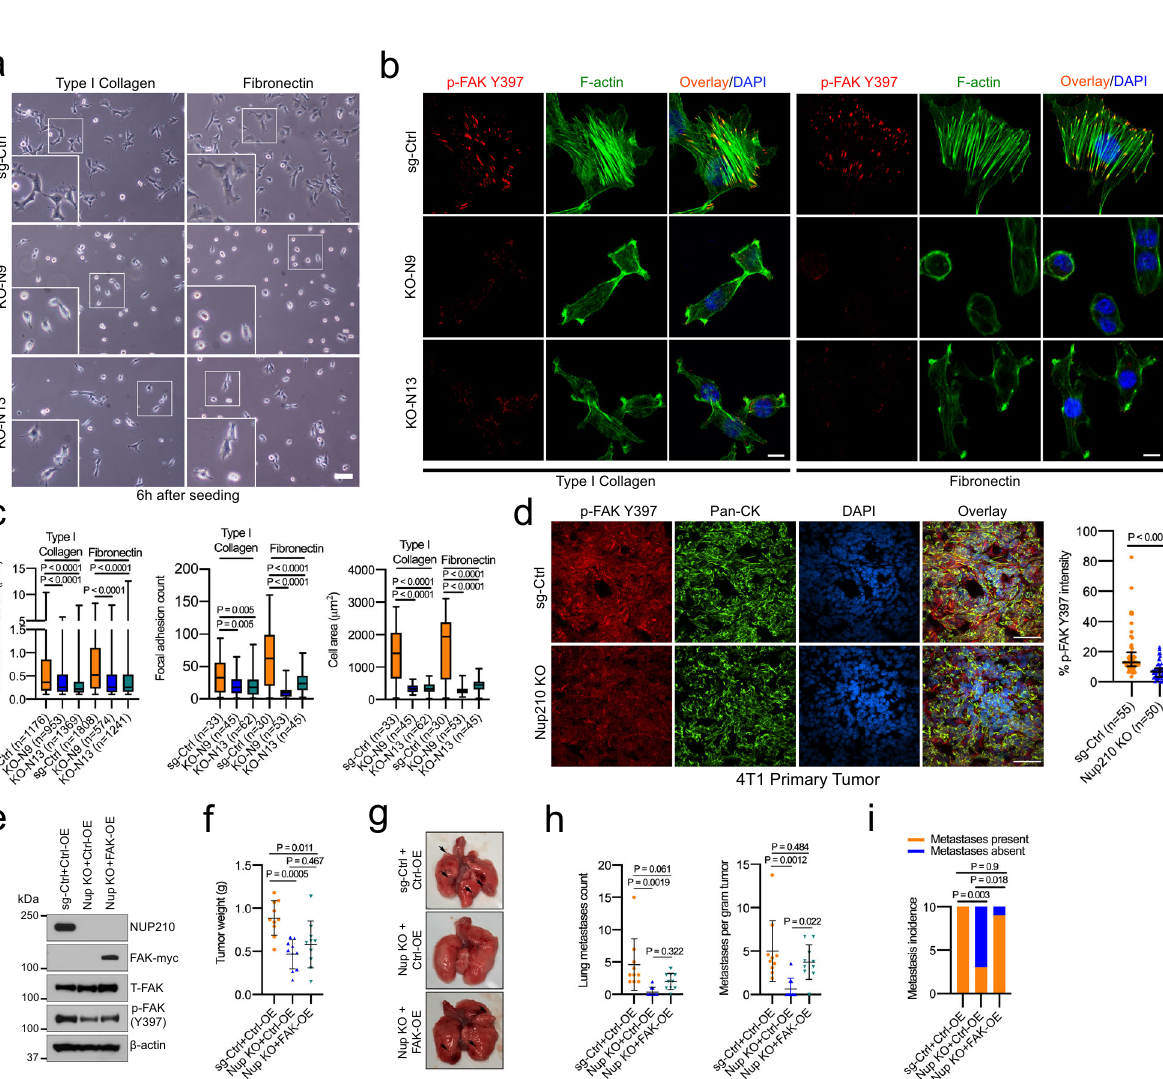
Fig. 5 Loss of NUP210 is associated with H3K27me3-marked heterochromatin spreading in 4T1 cells. a H3K27me3 peak enrichment on gene bodies in Nup210 KO cells within NUP210-enriched regions. b H3K27me3 ChIP-seq pro fi le in sg-Ctrl and Nup210 KO cells. c H3K4me3 ChIP-seq pro fi le on gene promoters in sg-Ctrl and Nup210 KO cells. d Overlap of genes with H3K4me3 loss on the promoter and downregulated expression in Nup210 KD cells. e Gene Ontology (GO) analysis of overlapped genes from ( d ). f qRT-PCR analysis of cell migration-related genes in Nup210 KO and KD 4T1 cells. Multiple two-tailed t test, mean ± s.e.m, n = 3 biological replicates (sg-ctrl vs Nup210 KO), n = 4 biological replicates (sh-Ctrl vs sh-Nup210). g Representative ChIP-seq (NUP210-, H3K27Ac-, H3K27me3- and H3K4me3) tracks with predicted TADs within Cxcl and Ccl2 region. h qRT-PCR analysis of cell migration- related genes in DMSO- and GSK126-treated Nup210 KO 4T1 cells. Multiple two-tailed t test, mean ± s.e.m, n = 3 biological replicates. i Representative images of H3.1/3.2 and H3K27me3 distribution in DMSO- and GSK126-treated Nup210 KO cells. Scale bar = 5 μ m. j H3.1/3.2 intensity ratio, H3K27me3 intensity and nuclear area quanti fi cation in DMSO- and GSK126-treated Nup210 KO 4T1 cells. Kruskal – Wallis ANOVA with Dunn ’ s multiple comparison test, error bar represents median with interquartile range. ‘ n ’ in X -axis is the number of cells analyzed per condition. k Live-cell tracking of a nuclear area in DMSO- and GSK126-treated Nup210 KO cells. n = 40 (sg-Ctrl), n = 41 (KO + DMSO), and n = 31 cells analyzed per conditions.